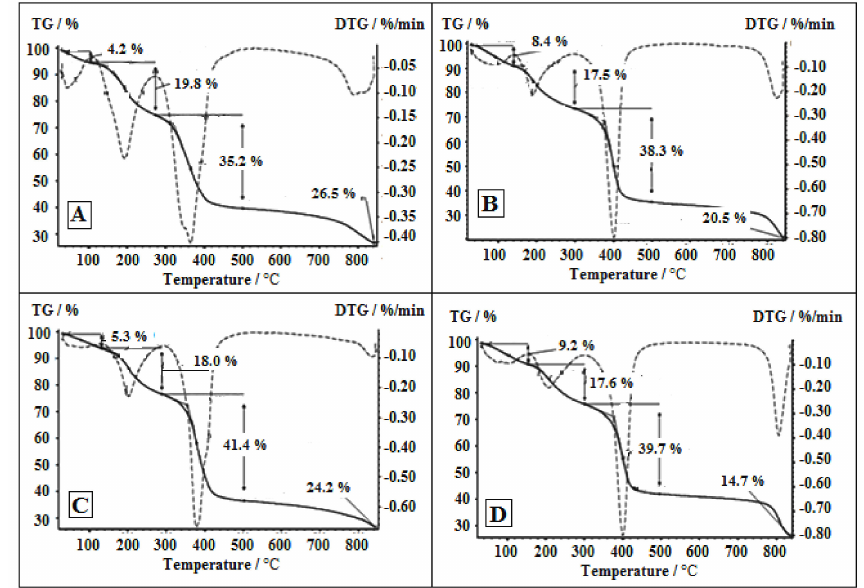
Figure 2. TG/DTG curves of the PhCP ( A ), Co-PhCP ( B ), Fe-PhCP ( C ), and Ni-PhCP ( D ). Heating rate: 1 K · min − 1